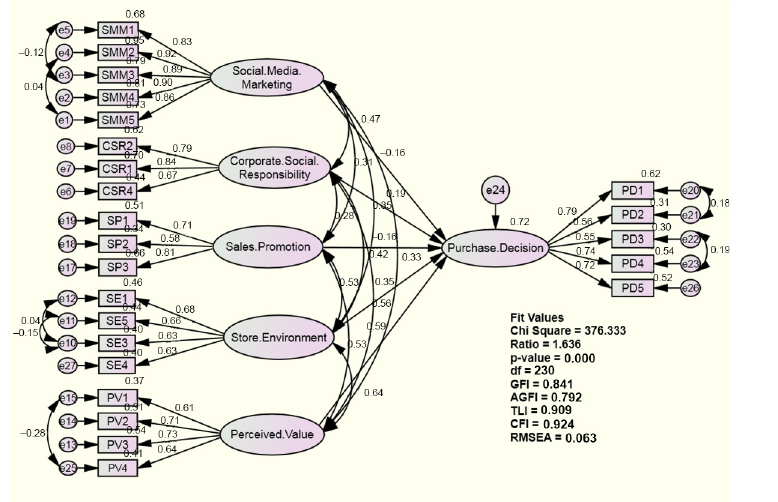
Figure 2. Structural